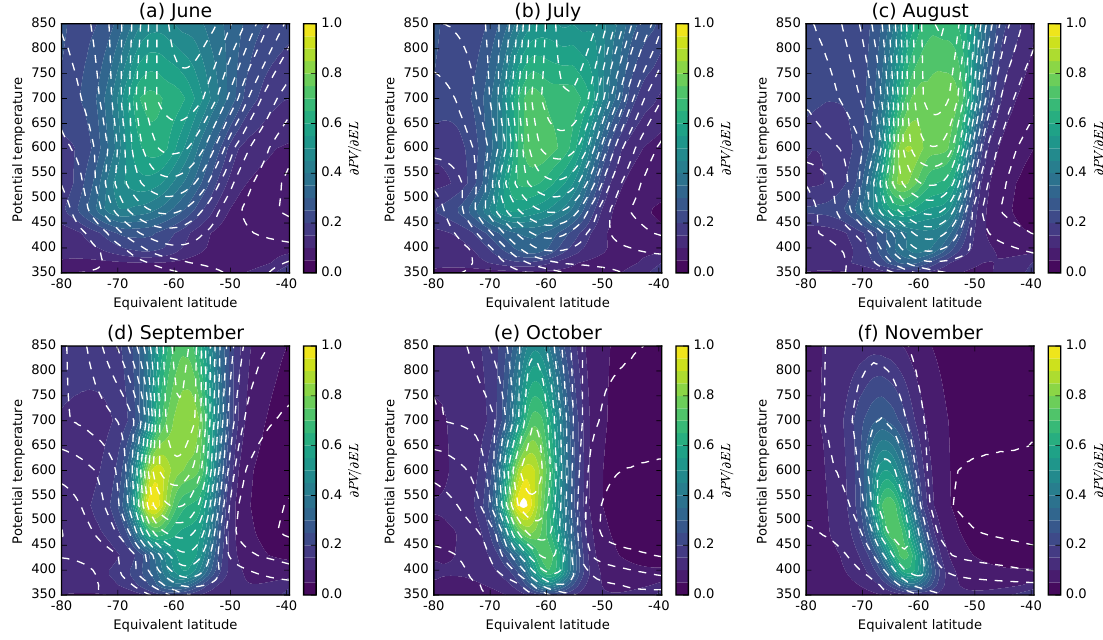
Figure 2. Monthly mean PV gradient (colours; sPVU ◦− 1 ) and wind speed (dashed lines; in 10ms − 1 steps) in 0.5 ◦ bins at ERA-Interim levels between 350 and 850K, for selected months, 1979–2016.